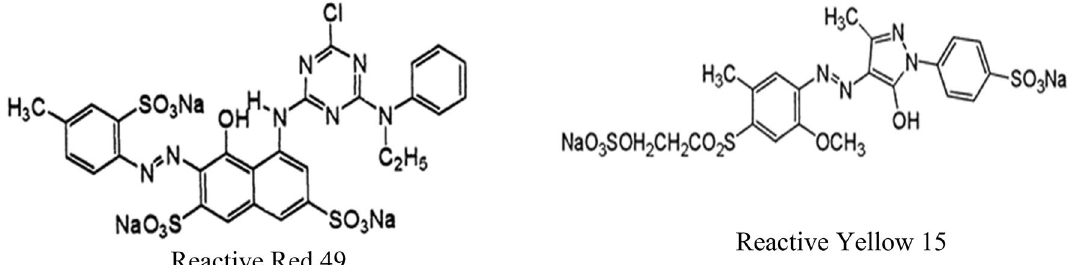
Fig. 1 Dyes chemical structures